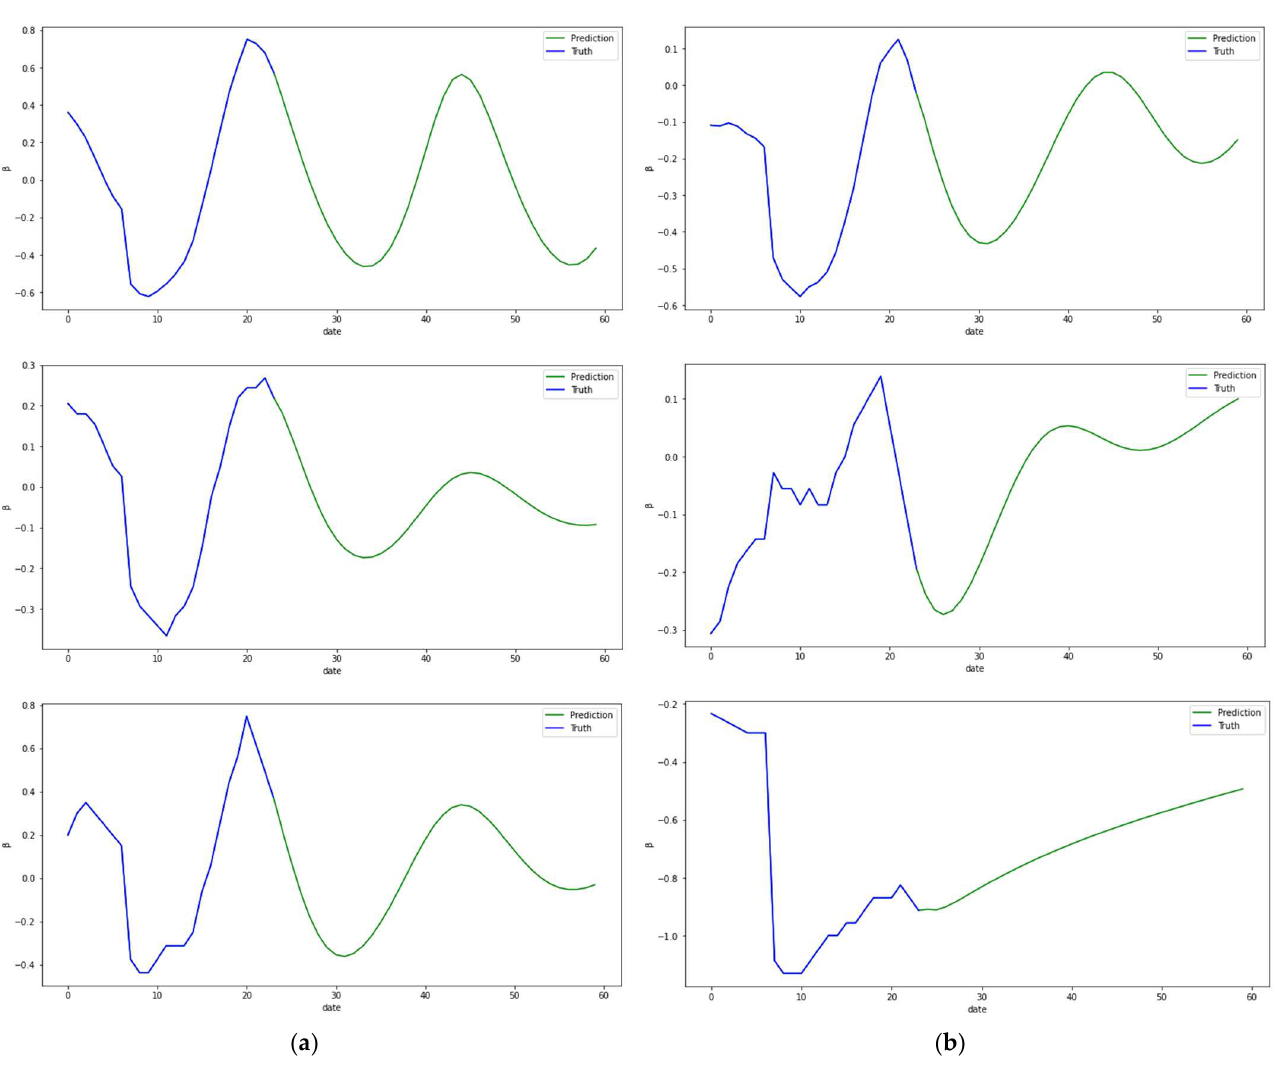
Figure 9. Predicted results of β syn , β wet , and β ws in Beijing ( a ) and Shanghai ( b ). (cid:16) (cid:11)X3 (cid:16) (cid:13)dc (cid:16) (cid:13)(cid:11) Tables 7 and 8 are used to calculate in Beijing and Shanghai based on the (cid:16)i cd) equation. Table 7. Predicted hourly variation coefficient of dry bulb temperature in Beijing.